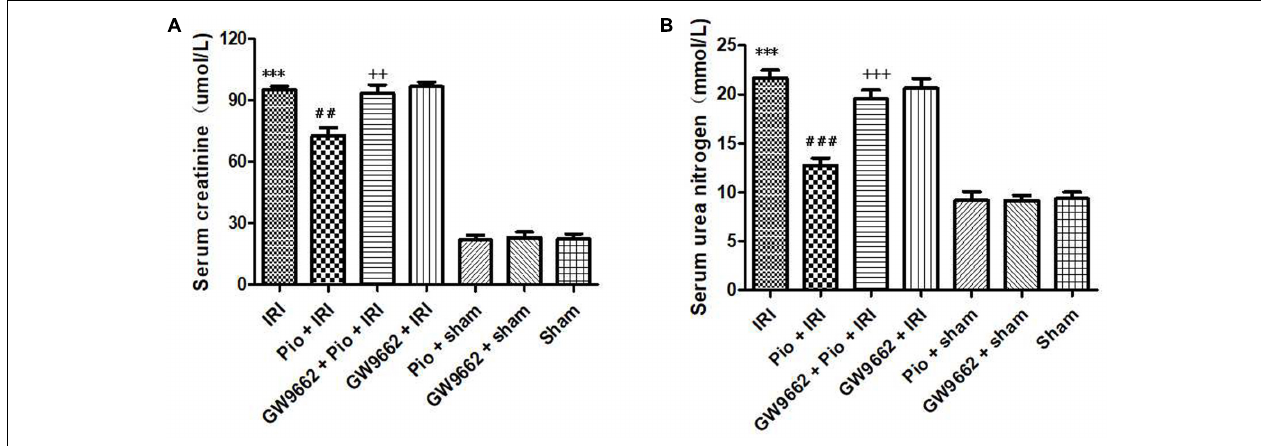
FIGURE 2 | Pioglitazone treatment improves renal IRI. (A) Serum creatinine levels in different groups at 24 h after renal IRI. (B) Serum urea nitrogen levels in different groups at 24 h after renal IRI. Values are expressed as mean ± SE ( n = 6). Compared to the sham group, ∗∗∗ represents p < 0.001; compared to the IRI group, ## represents p < 0.01, and ### represents p < 0.001; compared to the Pio + IRI group, ++ represents p < 0.01, and +++ represents p < 0.001.